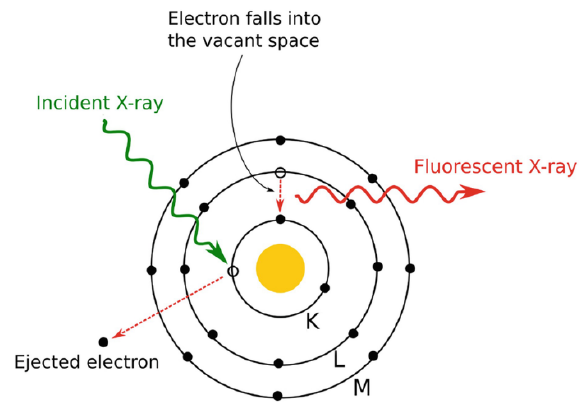
Figure 5. Principle of X-ray fluorescence [45].